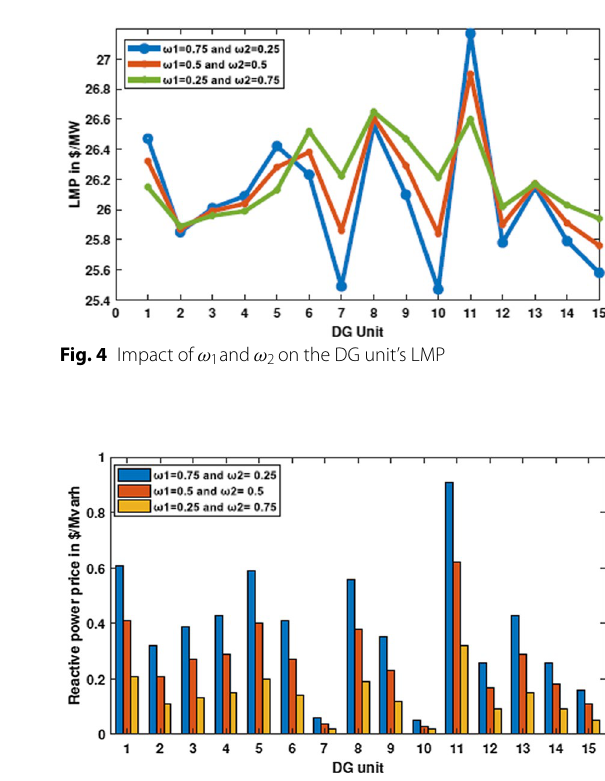
Fig. 5 Impact of ω 1 and ω 2 on the DG unit’s reactive power